Question: According to the figure, is the described quantity increasing or decreasing?
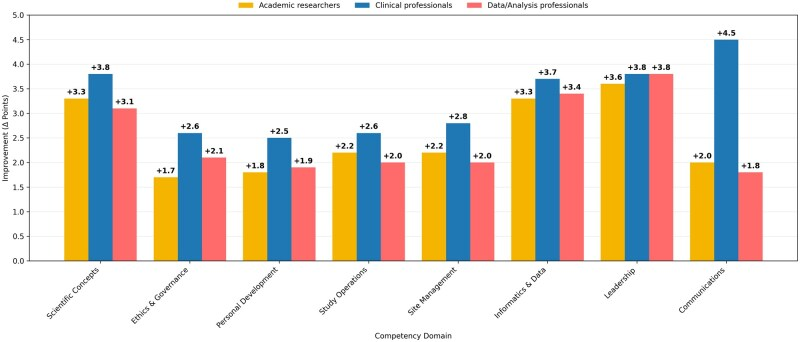
Answer: increasing